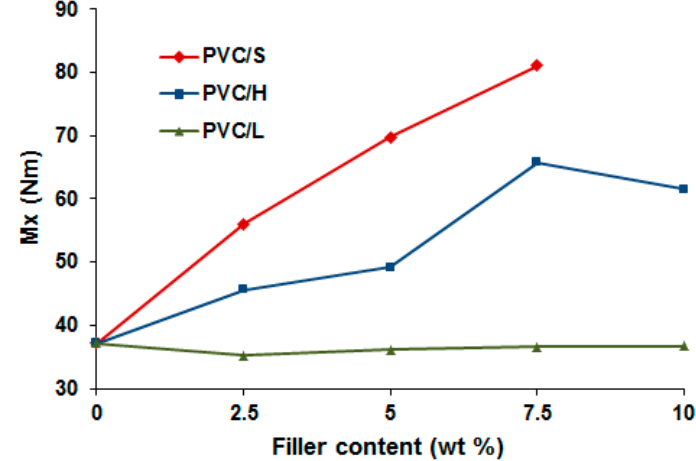
) for PVC and PVC composites as a function of X